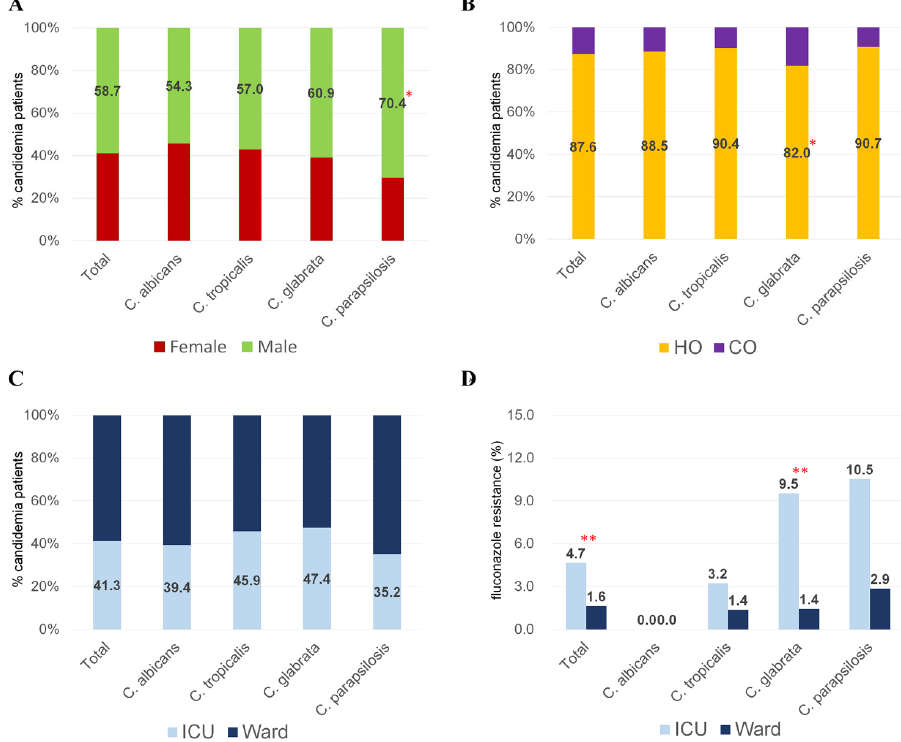
Figure 3. Clinical information of cases of candidemia caused by different Candida species: sex ( A ), origin (hospital origin [HO] or community origin [CO]) ( B ) and location (ICU vs. ward) ( C ). In ( A